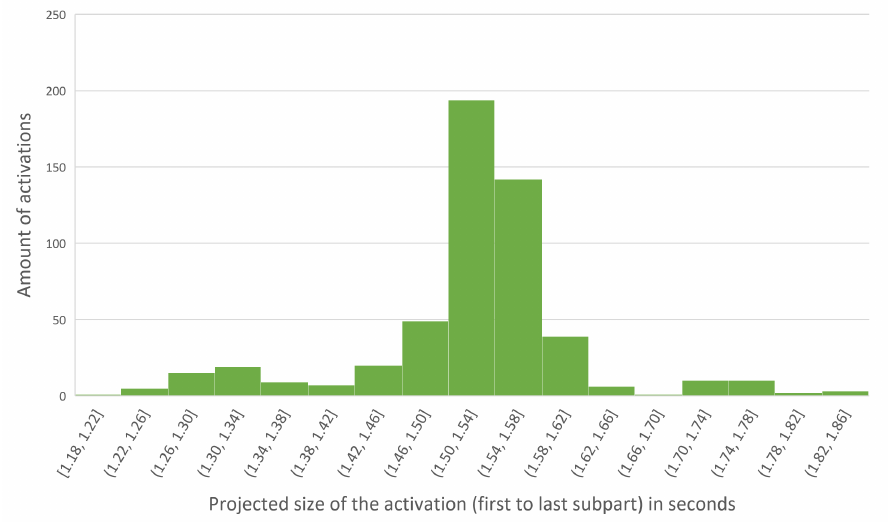
Figure 17. Varying activation sizes for a layer 2 part which activates on the 7/8 meter segments. The majority of activations is within 100 milliseconds of the average size of 1.52 seconds (about 6% difference in tempo); however, many occurrences also range from about 25% slower up to 25%